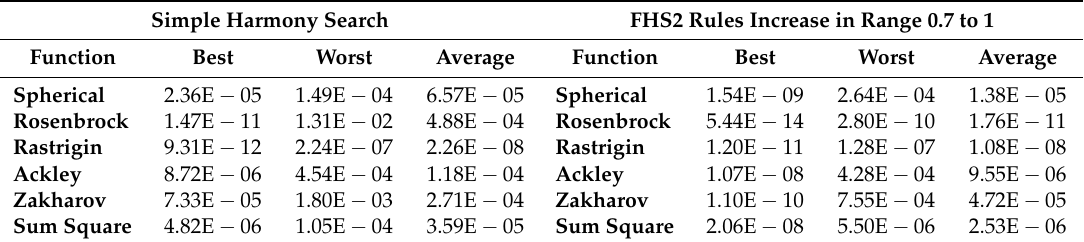
Table 8. Comparison results obtained with FHS2 and the harmony search